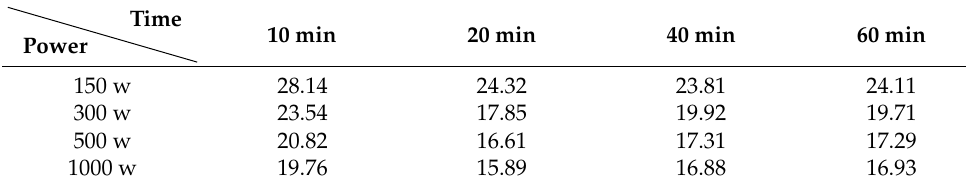
Table 3. Bonding ratios of different times and